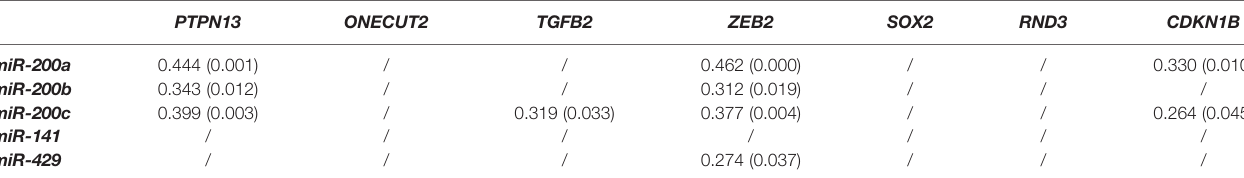
TABLE 5 | Comparison between the miR-200 family and investigated genes expression (Spearman correlation coef fi cients and corresponding p-values in brackets). PTPN13